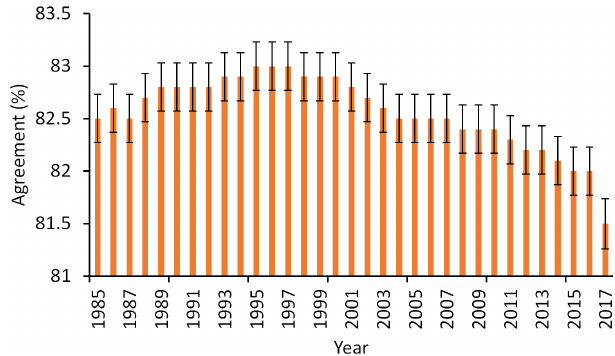
Figure 10. Overall agreement between LCMAP primary land cover and reference data across CONUS. The black error bars represent ± 1 standard